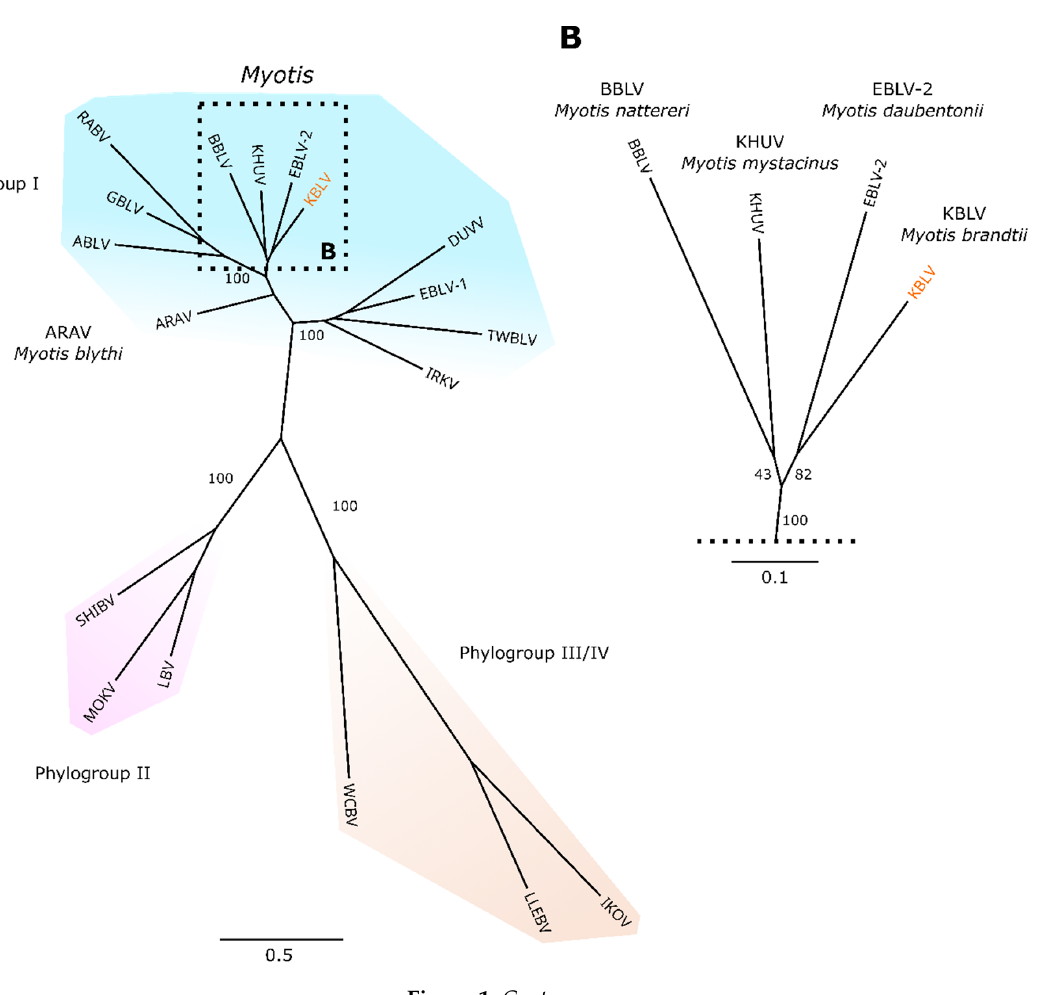
Figure 1. ( A ) ML-Phylogenetic tree based on full-genome sequences of representatives of the 17 different lyssavirus species and their respective affiliation to one of the four designated phylogroups (I-IV) ( B ) Enlarged part of the tree showing the lyssaviruses most closely related to KBLV and the bat species they were isolated from; ( C ) The 11,878 nt long sequence of the Kotalahti bat lyssavirus (KBLV) genome reflects the characteristic gene organization known for lyssaviruses encoding for the five viral proteins: nucleoprotein (N), phosphoprotein (P), matrix protein (M), glycoprotein (G) and the RNA- dependent RNA polymerase (L). * Sequence depth of the 5 ′ UTR was not sufficient at the final part to verify nucleotides. 3.3. Expression of KBLV Proteins in Transfected Cells To assess expression, intracellular distribution, and antigenicity of the predicted KBLV glycoprotein, expression plasmid vectors were constructed by insertion of the re- spective ORF as a synthetic cDNA. At one day after plasmid transfection, the KBLV and RABV G proteins were comparably detected at the cell surface by the monoclonal anti- body E559 and intracellularly by a serum raised against EBLV-2 G (Figure 2).